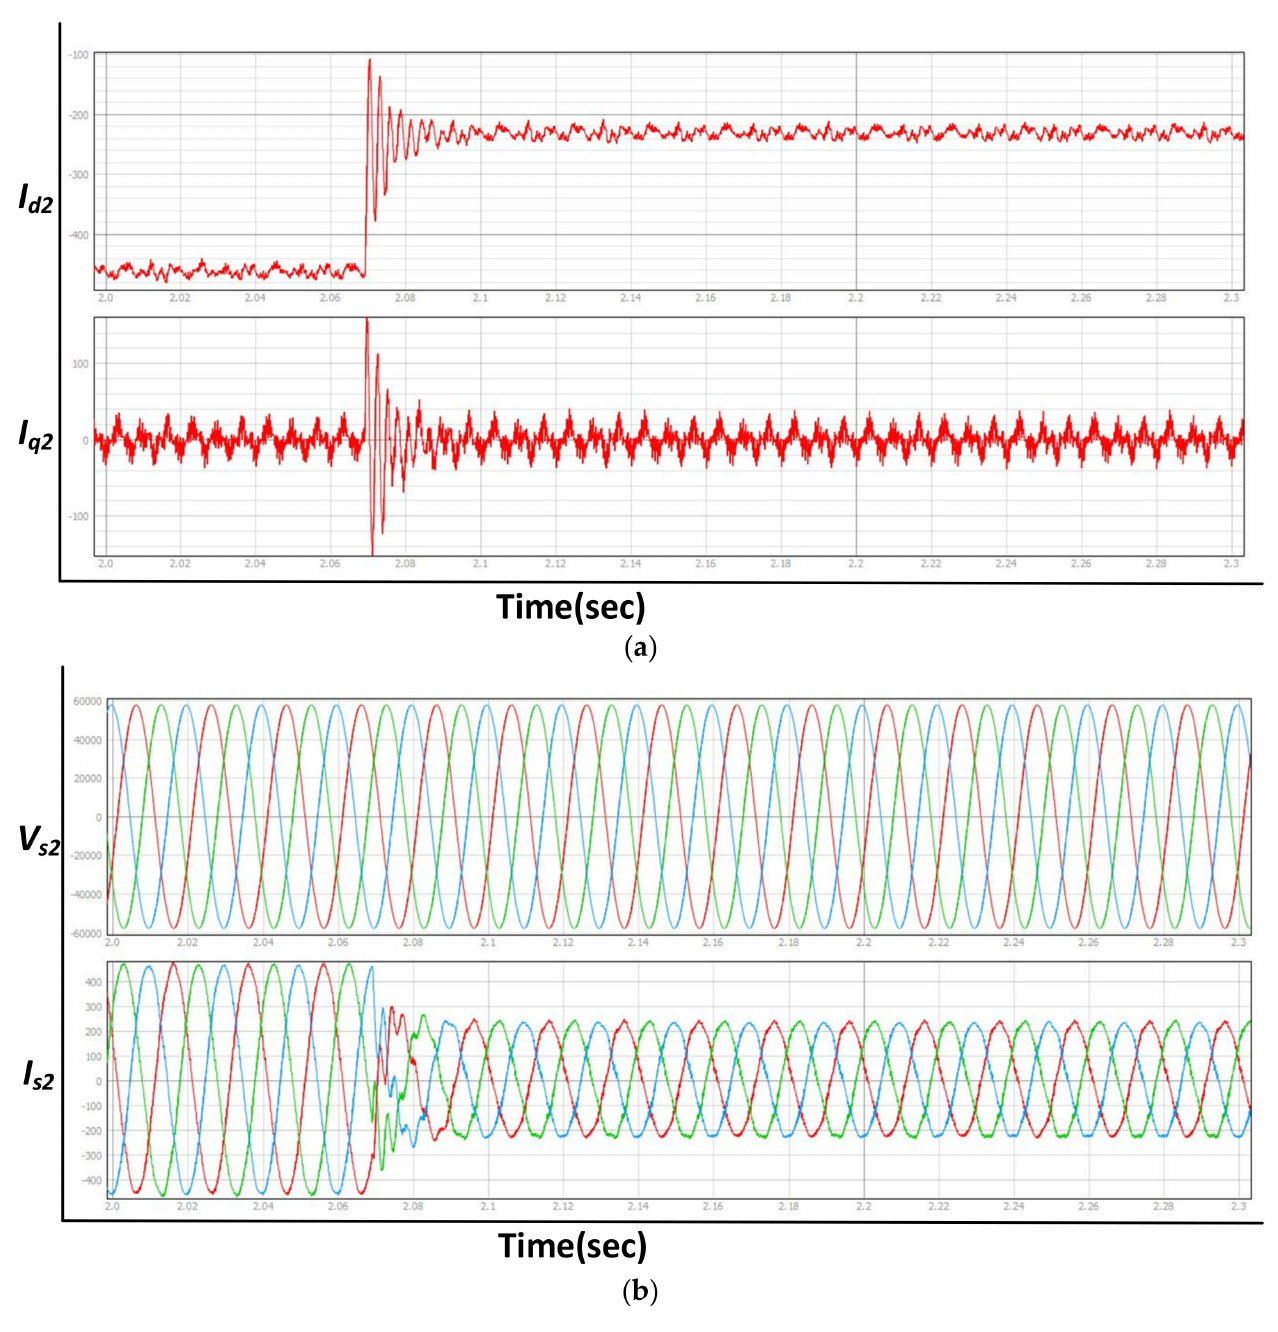
Figure 20. ( a ): Experimental results for the nominal case for I d2 , I q2 of Station 2 for a 50% step change in active power; ( b ): experimental results for the nominal case for V s2 (three phase votlages) and I s2 (three line currents) of Converter Station 2 for a 50% step change in active